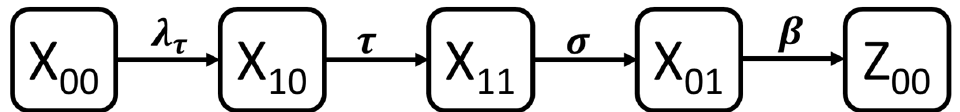
Figure 1. Schematic diagram of the dynamic model structure for RT-PCR and serology